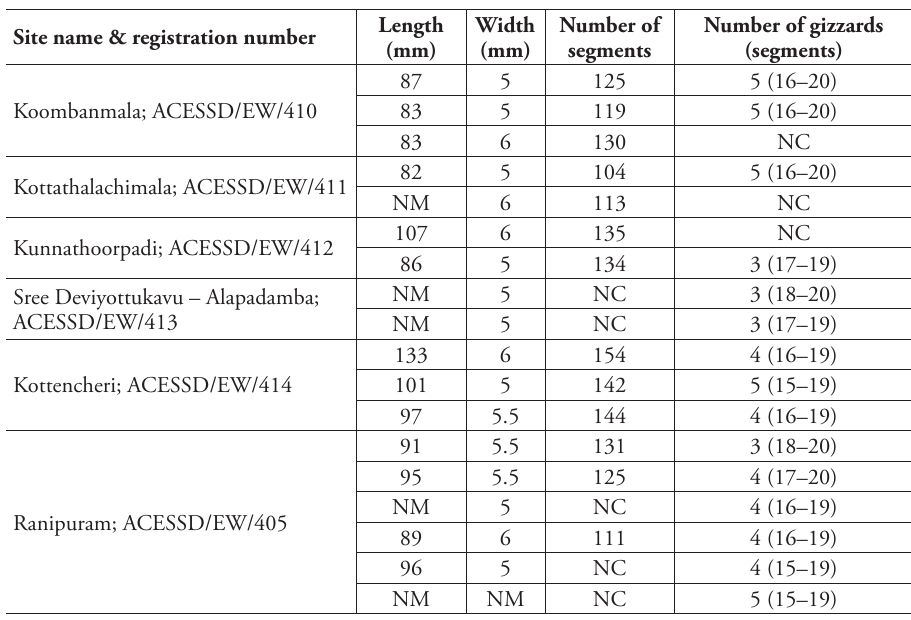
Table 4. Length, width, number of segments, and number of gizzards in selected specimens of Drawida somavarpatana from various